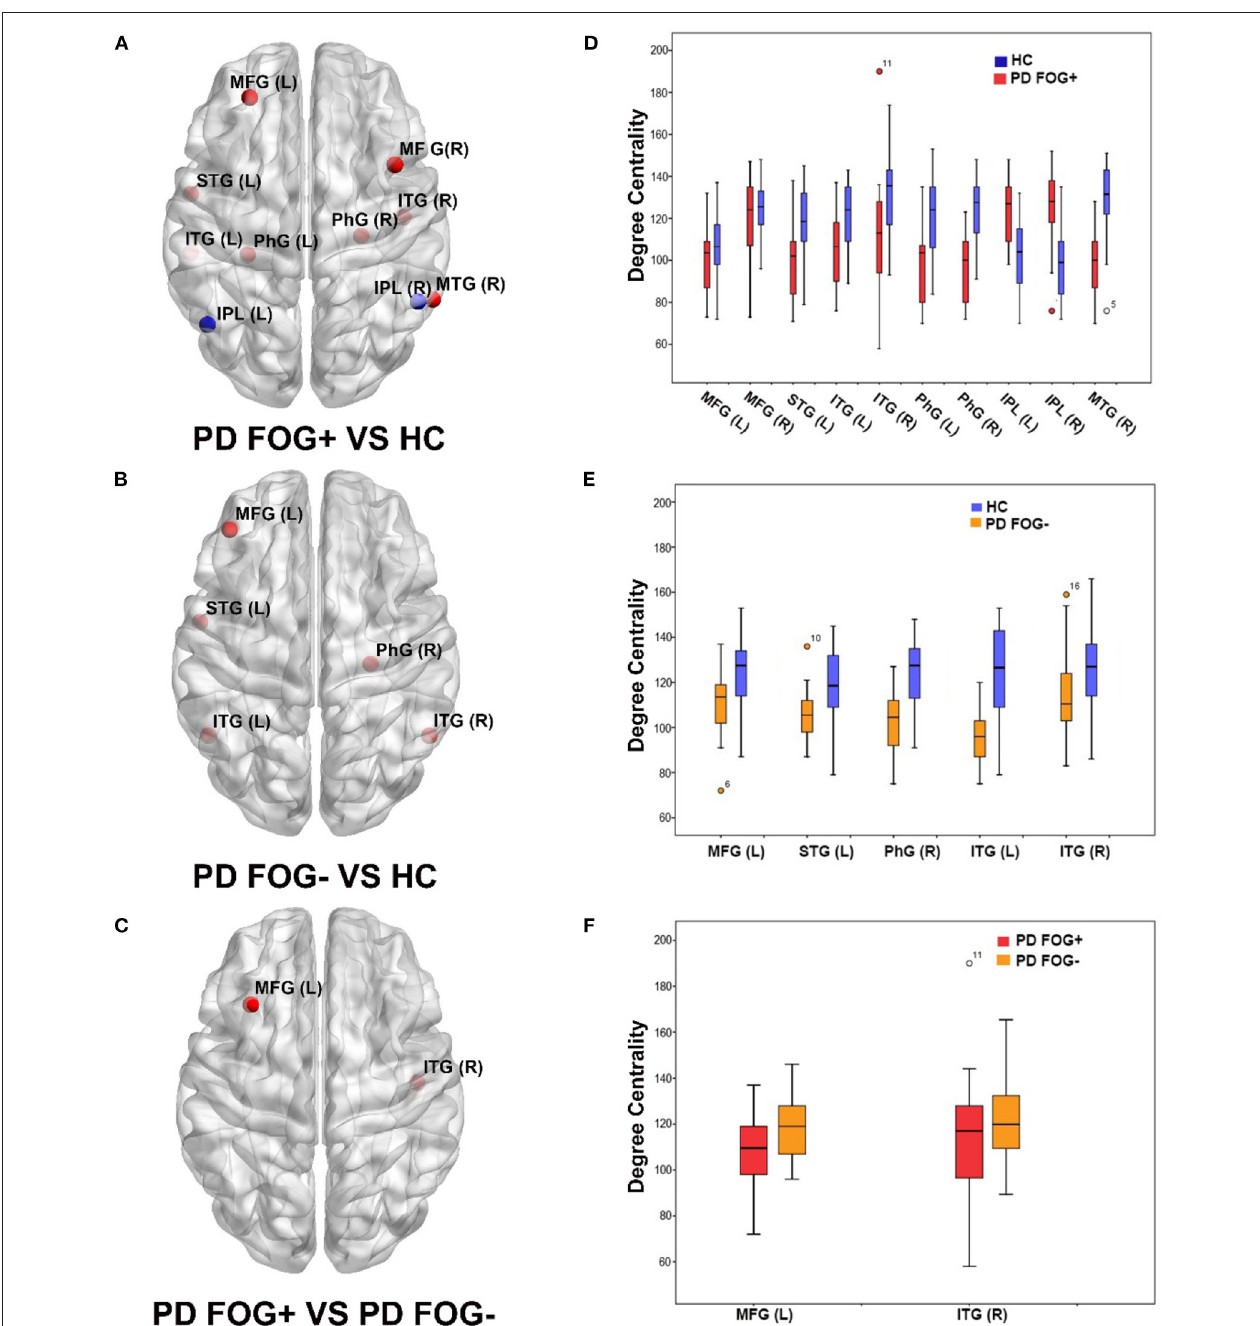
FIGURE 2 | Brain regions showed significant differences in degree centrality (DC) among three groups ( p < 0.05, FDR correction). (A) Brain regions with significant DC in PD FOG + vs. HC. (B) Brain regions with significant DC in PD FOG– vs. HC. (C) Brain regions with significant DC in PD FOG + vs. PD FOG–. (D) DC values of brain regions showing significant differences in PD FOG + vs. HC. (E) DC values of brain regions showing significant differences in PD FOG– vs. HC. ( F ) DC values of brain regions showing significant differences in PD FOG + vs. PD FOG–.